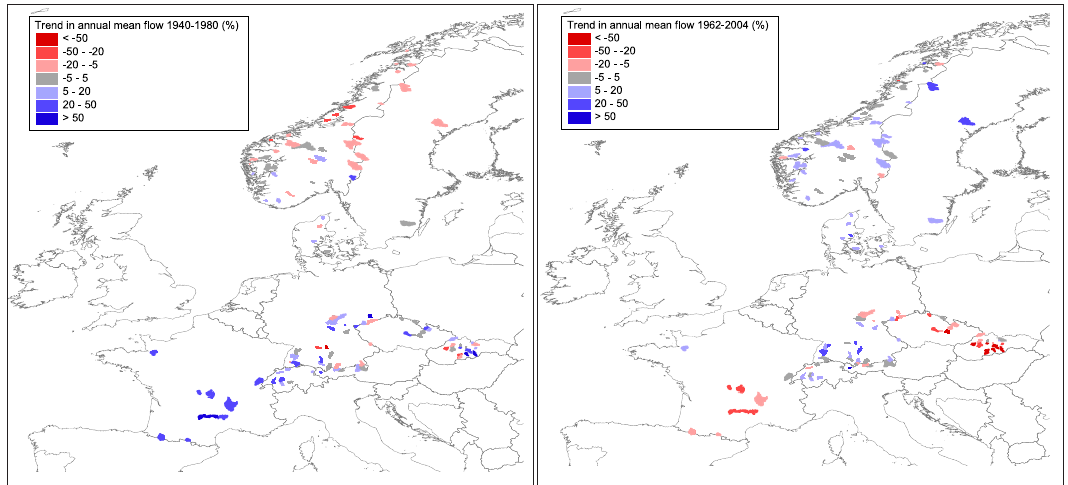
Fig. 8. Comparison of trends in annual mean flow for the fixed 1940–1980 period with the 1962–2004 period (using the same trend testing approach as Stahl et al.,